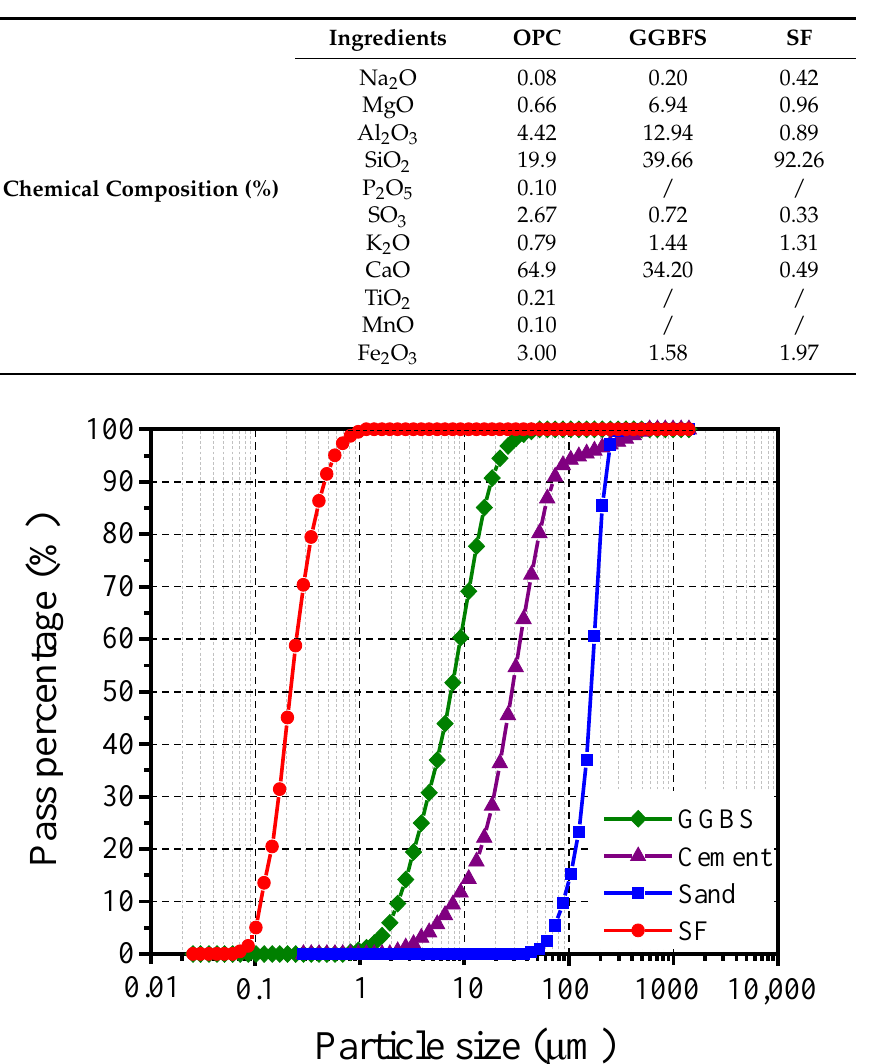
Table 1. Chemical properties of cement, silica fume, and ground granulated blast furnace slag (GGBFS).